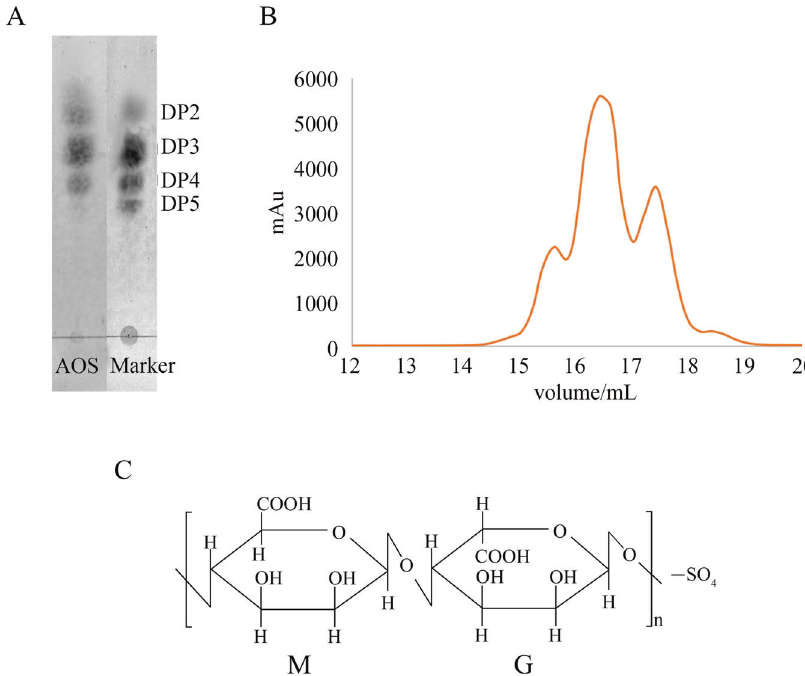
Fig. 1 Characterization of AOS. A The composition of AOS was identi fi ed by TLC assay. B Size exclusion chromatography was performed using an ÄKTA puri fi er system. The prepared alginate oligosaccharides were loaded onto a Sephadex G-15 column monitored at 235 nm, which was eluted with 0.2 M ammonium bicarbonate at a fl ow rate of 0.3 ml/min. C Schematic representation of the molecular structure of AOS and sulfated AOS (AOS-SO 4 ) prepared by enzymatic